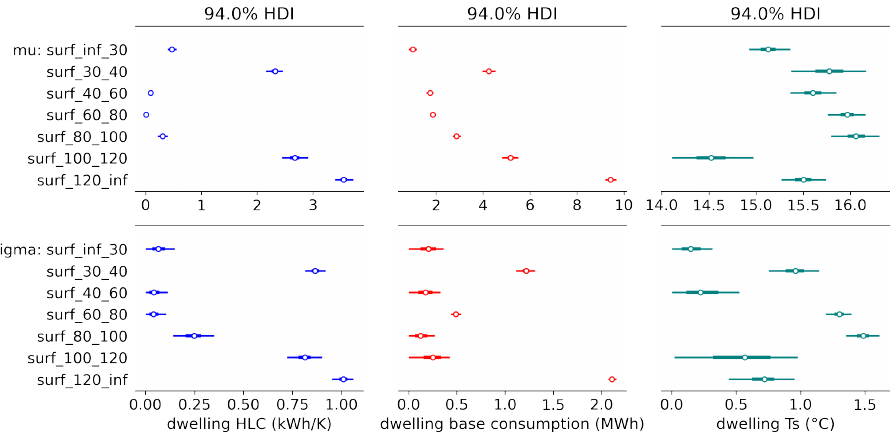
Figure 12. Inference results for surfaces